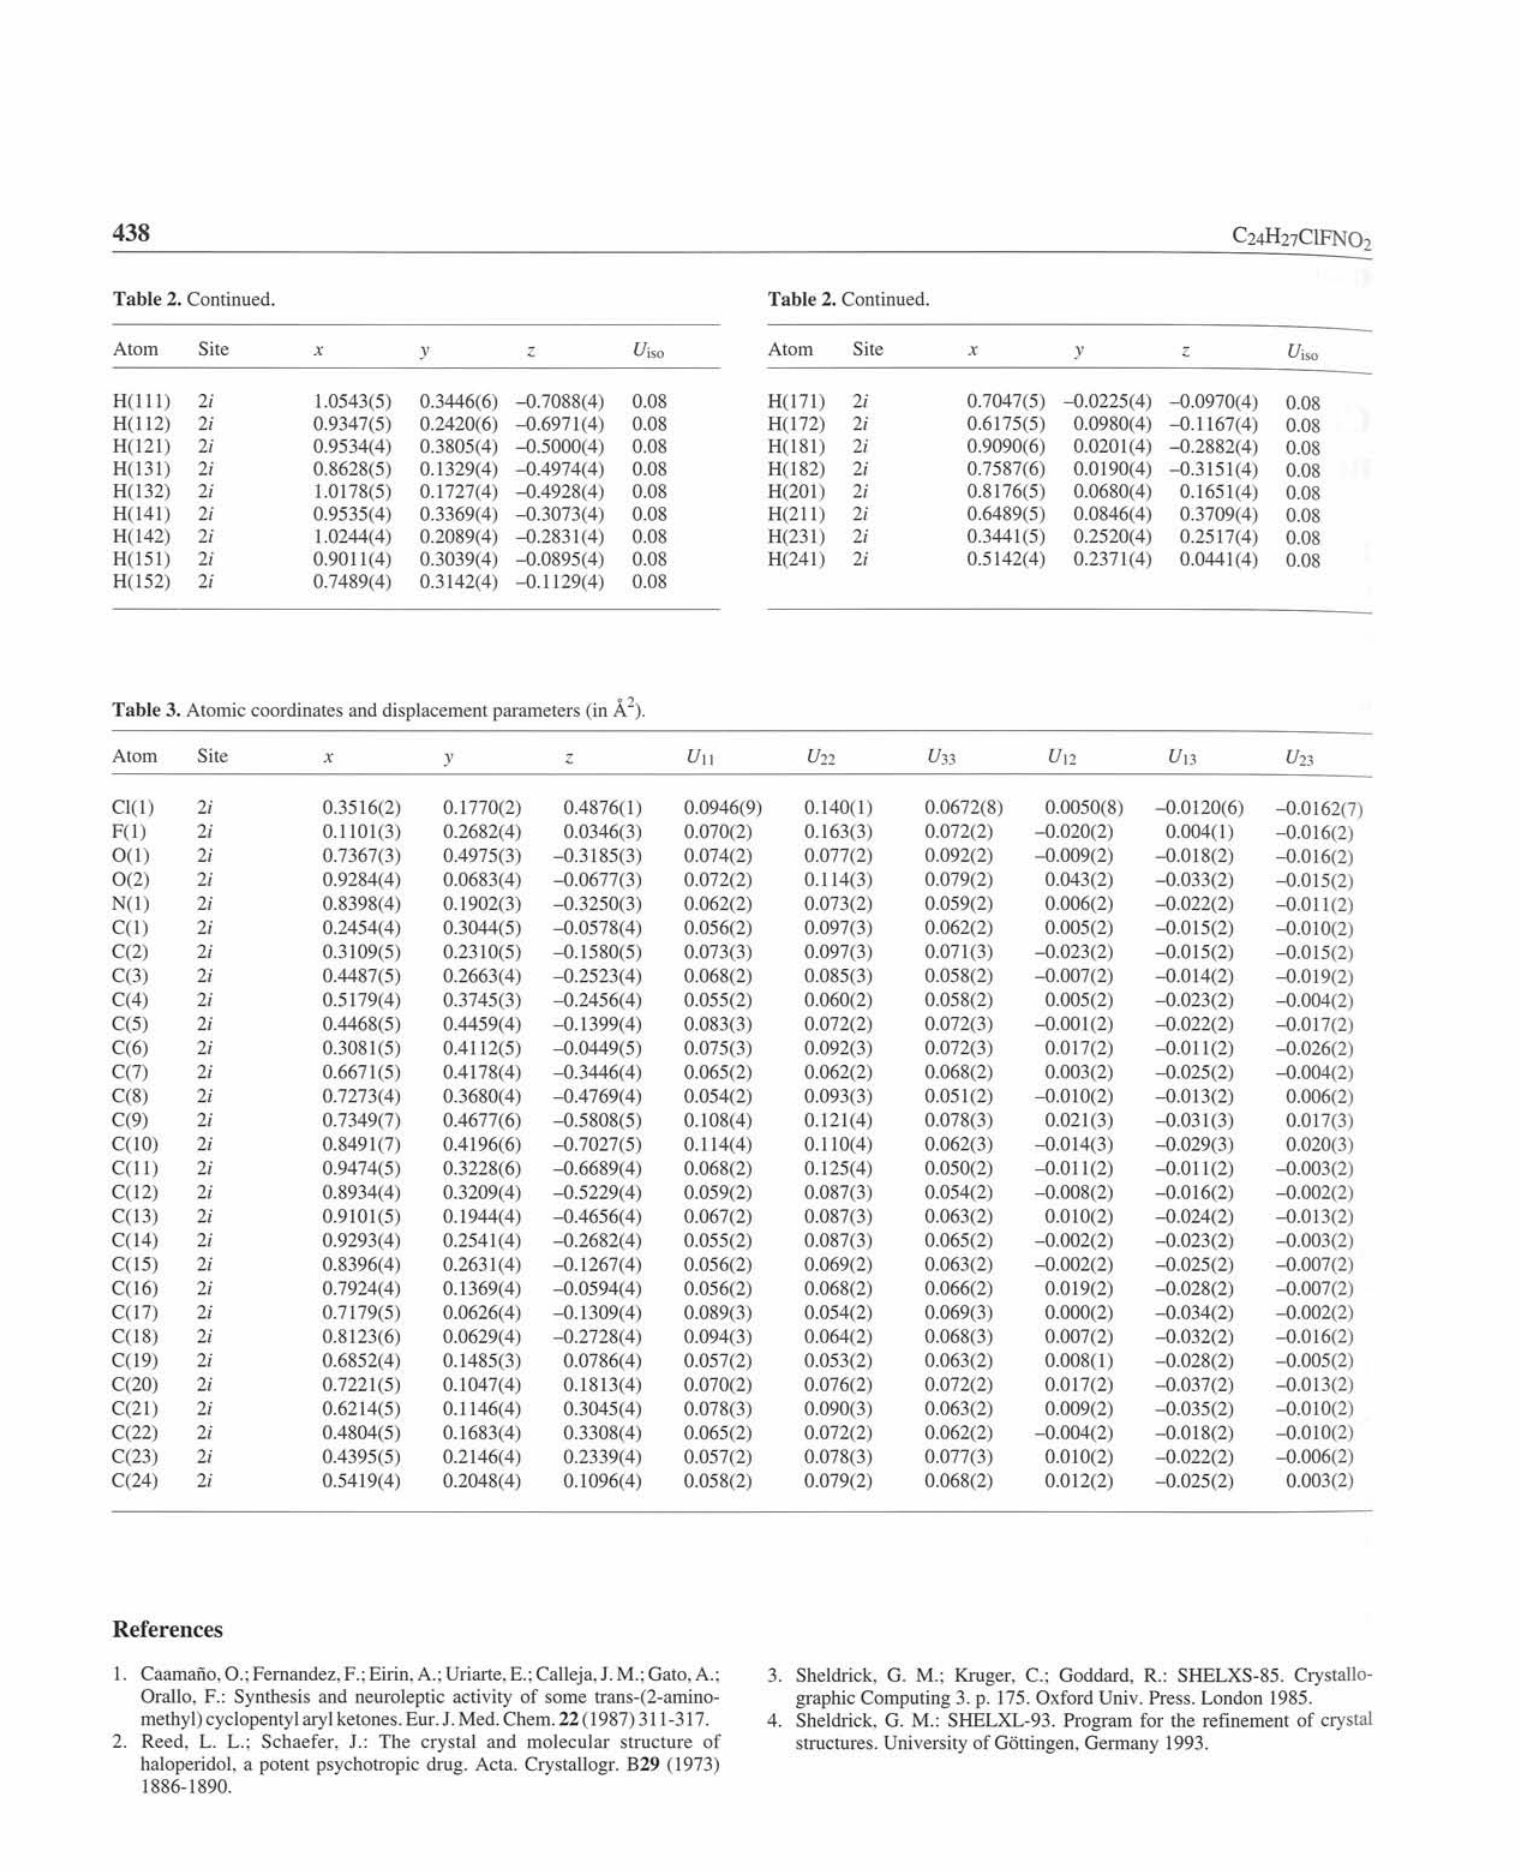
Table 3. Atomic coordinates and displacement parameters (in Â